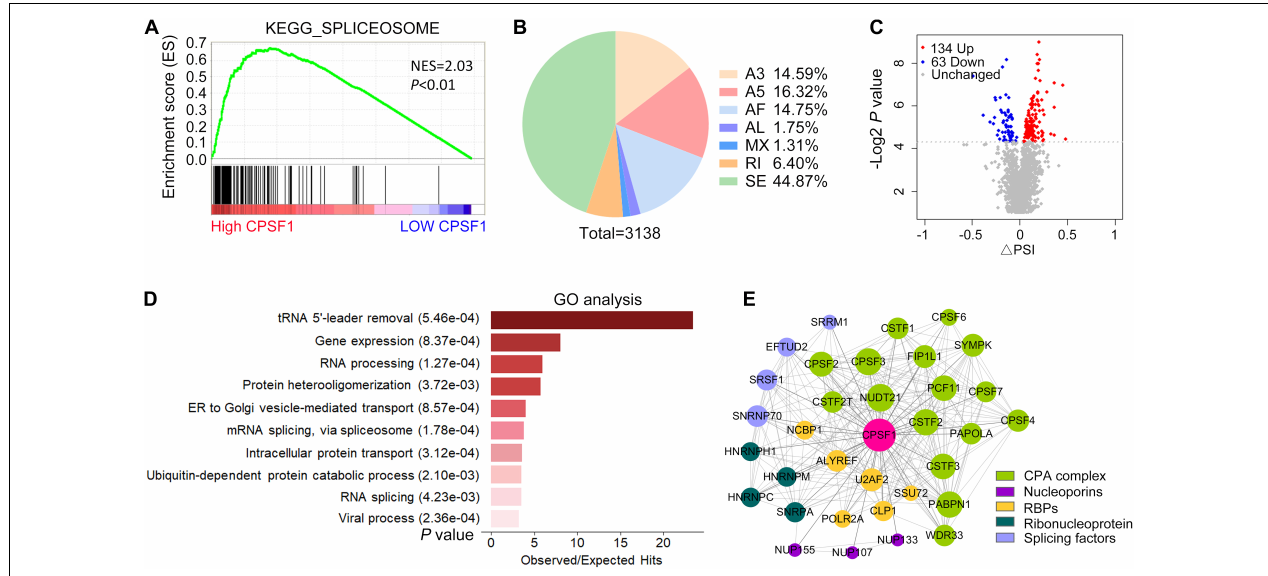
FIGURE 7 | Alternative splicing profiles regulated by CPSF1 in HepG2.2.15 cells. (A) GSEA plot showing the correlation between high CPSF1 expression and spliceosome functions. Black vertical lines indicate the gene that correlated with CPSF1 in the gene set. (B) Pie chart illustrating the distribution of various types of AS events affected by CPSF1 knockdown as revealed by analysis of RNA-seq data. (C) Scatterplot showing the differential AS events identified between the CPSF1-silenced and control groups. (D) Barplot listing the top 10 significantly enriched GO biological processes. (E) Protein–protein interaction network showing the interaction between CPSF1 and related proteins. The top significant interactions with confidence > 0.95 in the STRING database are included. The size of the nodes and line width indicate the interaction degree and confidence,